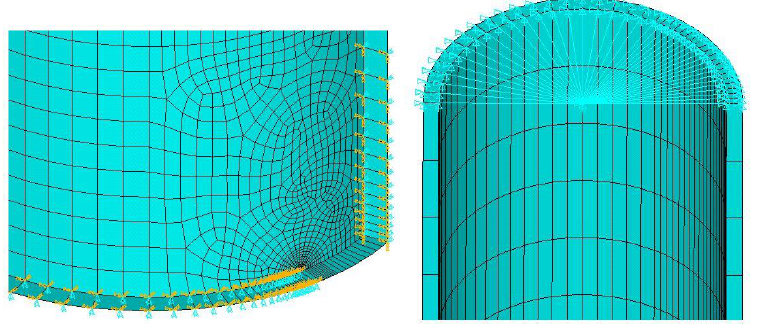
Figure 14. Symmetry surfaces and symmetry conditions for a circumferential crack. Figure 13. Finite element model of thin-walled cylindrical shell model with circumferential crack.